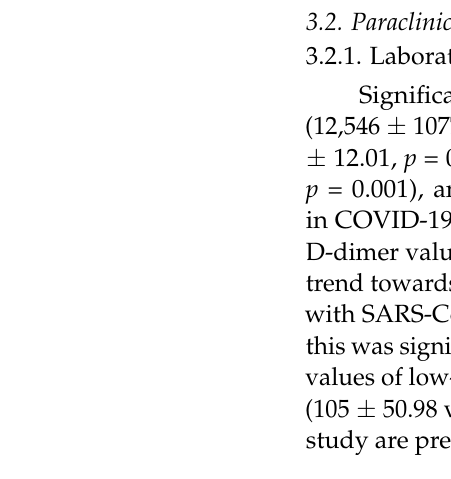
Table 2. Laboratory findings for patients included in the